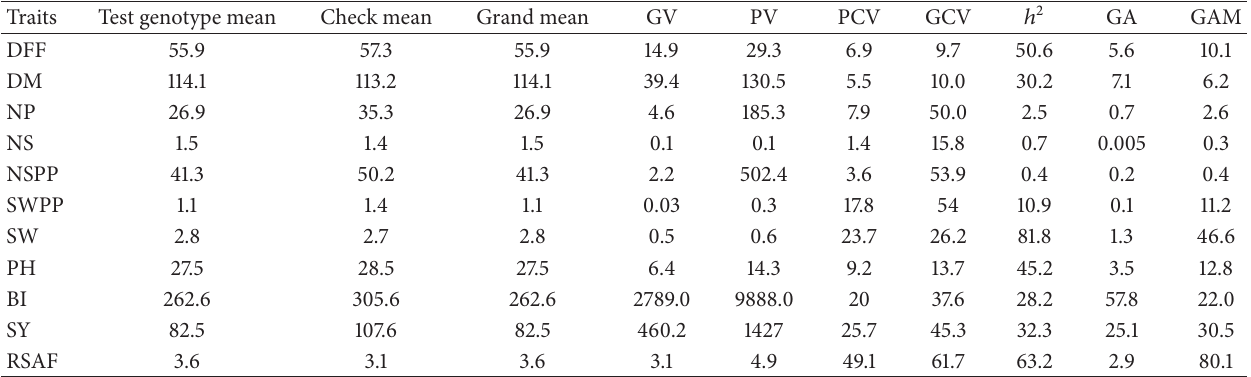
Table 10: Genetic parameter estimates for agromorphological characters of lentil genotypes at Chefe Donsa 2011/12 cropping season. Traits Test genotype mean